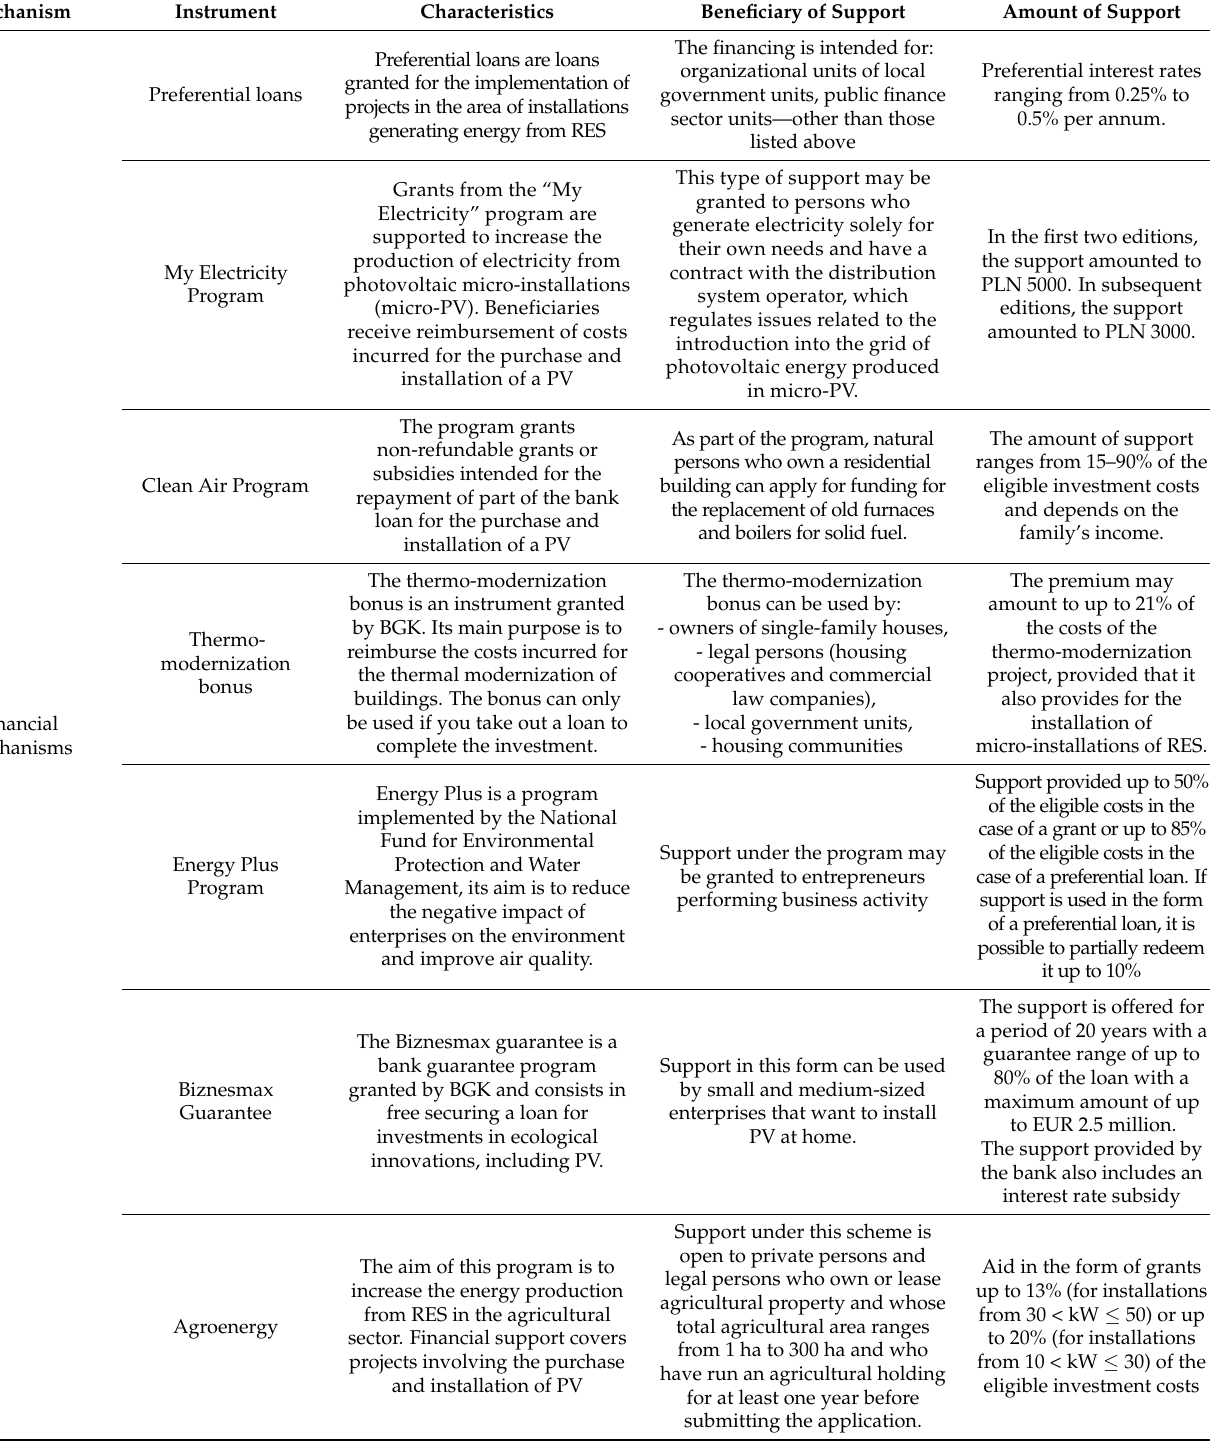
Table 3. Characteristics of the support mechanisms for RES in force in